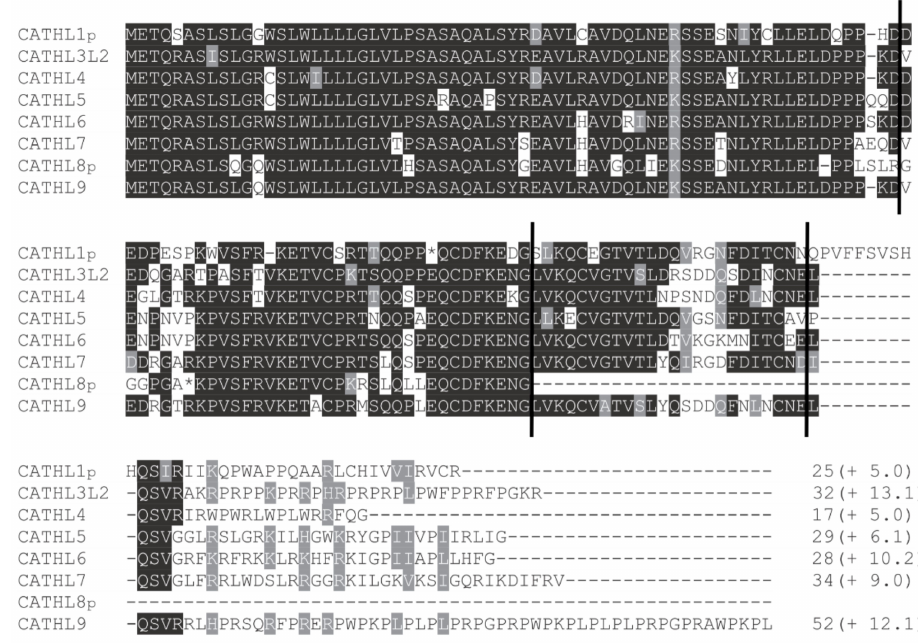
Figure 1. Multiple sequence alignment of forest musk deer cathelicidins. The positions of four exon boundaries are indicated by vertical lines, and conserved residues are shaded. The predicted C-terminal mature peptides are shown with the lengths and net charges (in parenthesis). The mature peptides of the forest musk deer cathelicidin genes were predicted based on the amino acid alignment of other cathelicidin genes, and the net charge of each mature peptide was estimated by using the on-line software at https: // pepcalc.com /